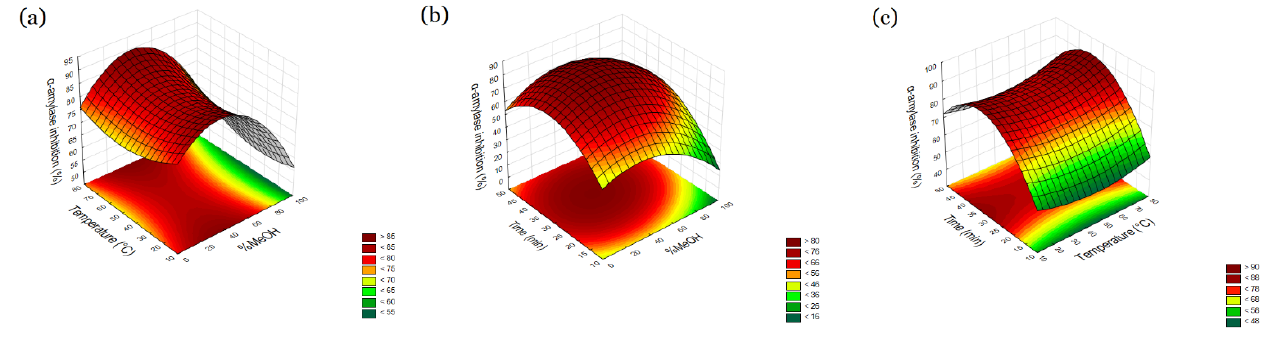
Figure 2. Response surface and contour plots percent of α -amylase inhibition as a function of methanol concentration (X 1) and temperature (X 2 ) ( a ), methanol concentration (X 1) and time (X 3 ) ( b ), temperature (X 2 ) and time (X 3 ) ( c ).